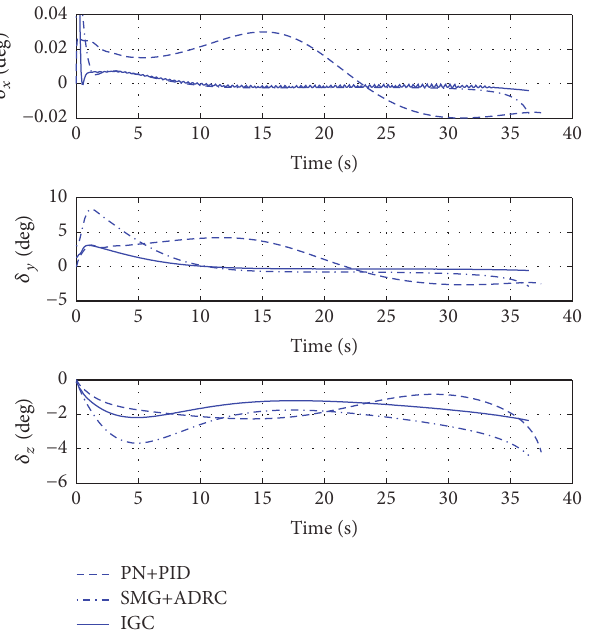
Figure 8: The range of attack angle, sideslip angle, and roll angle with respect to time in Scenario 2.